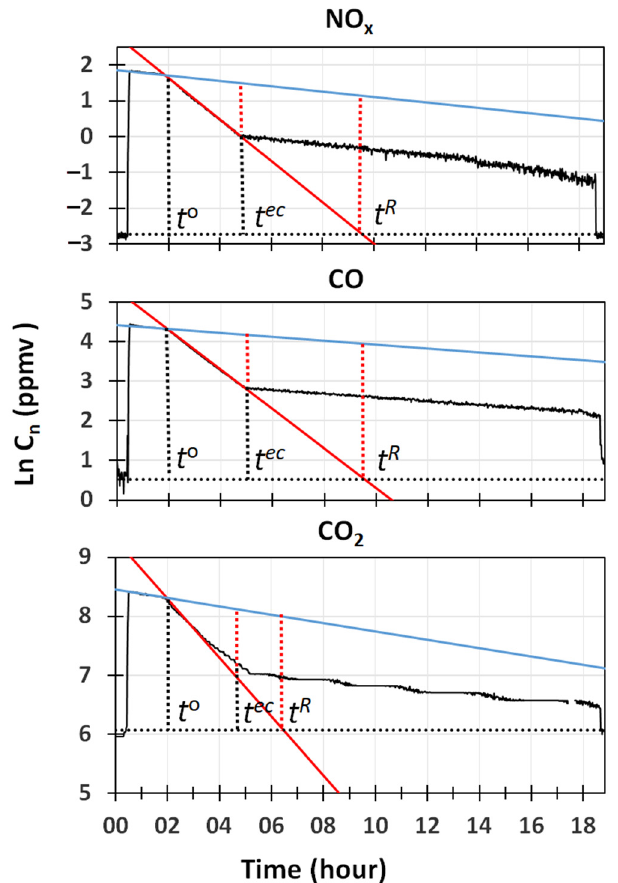
Figure 4. Semi-logarithmic plots of the mixing ratios of NOx, CO and CO 2 vs. time recorded in the testing room during the experiments performed with diesel exhaust emission, using the GIOEL air cleaner run at the minimum suction rate of air. The meaning of the lines and symbols is the same as in Figure 3.